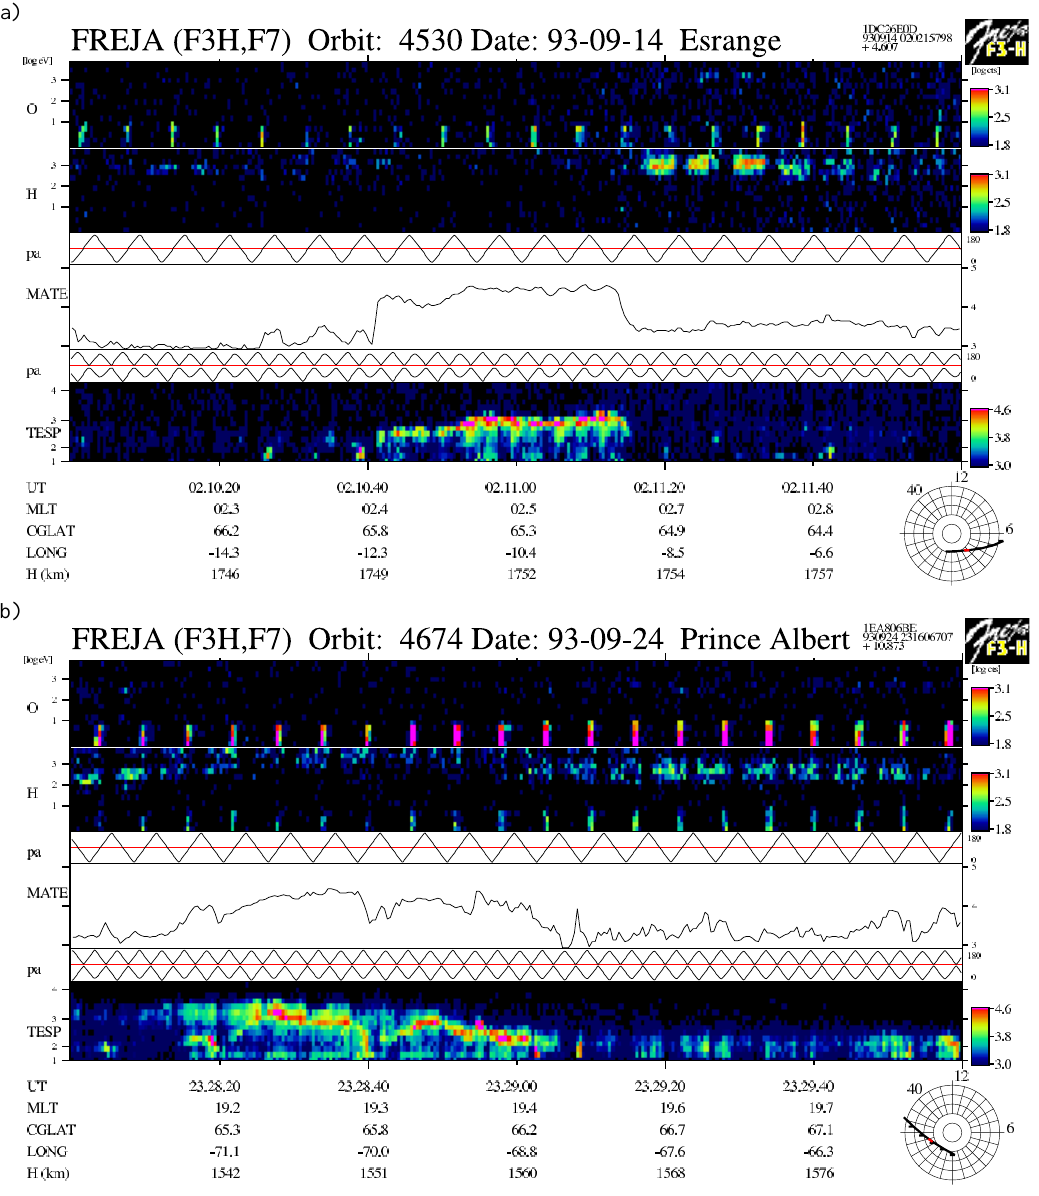
Fig.25. Illustrations of relationships of ion precipitation to intense precipitation of electrons with energy spectra of inverted-V type. In (a) is shown an intense inverted-V event with no coinciding precipitating ions but with strong ion precipitation next to it. In (b) weak fluxes of precipitating H + ions are observed during the whole period with inverted Vs and the ion energy is higher in the inverted Vs than outside.